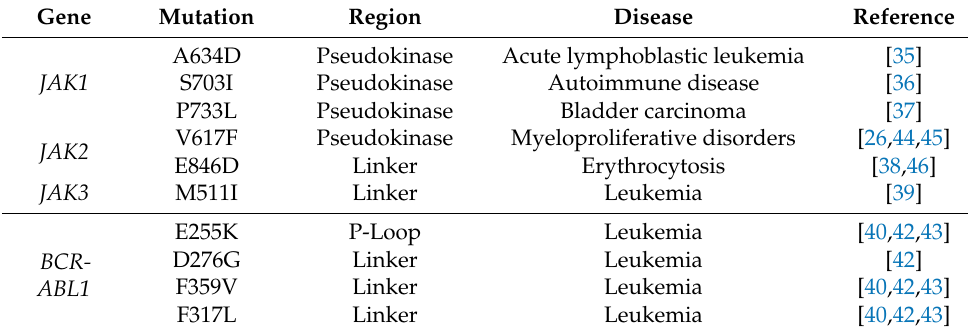
Table 1. Mutations in tyrosine kinases associated with STAT5-driven